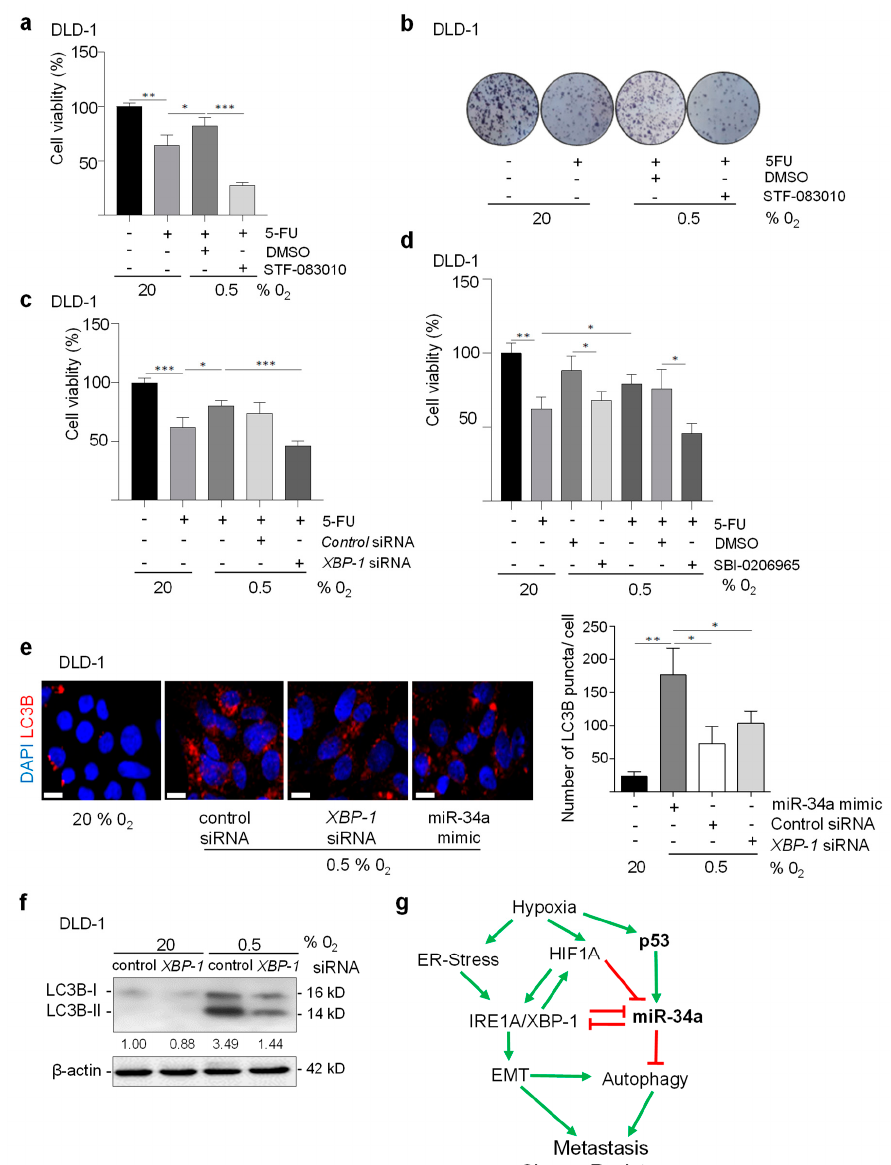
Figure 8. Induction of XBP-1(S) is required for hypoxia-induced autophagy and chemo-resistance. ( a ) MTT assay of DLD-1 cells treated with DMSO or STF-083010 for 24 h at 20.0% O 2 , then exposed to 0.5% O 2 for 48 h, and subsequently treated with or without 5-FU for 72 h. ( b ) Representative examples of crystal violet staining of DLD-1 cells treated with DMSO or STF-083010 for 24 h at 20.0% O 2 , then exposed to 0.5% O 2 for 48 h, and subsequently treated with or without 5-FU for 72 h. ( c ) MTT assay of DLD-1 cells transfected with XBP-1 or control siRNAs for 24 h at 20.0% O 2 , then exposed to 0.5% O 2 for 48 h, and subsequently treated with or without 5-FU for 72 h. ( d ) MTT assay of DLD-1 cells treated with DMSO or SBI-0206965 (10 µ M) for 24 h hours at 20.0% O 2 , then exposed to 0.5% O 2 for 48 h, and subsequently treated with or without 5-FU for 72 h. ( e ) Indirect immunofluorescence detection of LC3B in DLD-1 cells transfected with XBP-1 , control siRNAs or pre-miR-34a for 24 h then exposed to 0.5% O 2 for 48 h. ( f ) Western blot analysis of LC3B in DLD-1 cells transfected with XBP-1 or control siRNAs exposed to 20% or 0.5% O 2 for 48 h. ( g ) The HIF1A/IRS1A/XBP1/miR-34a regulatory circuit: Schematic model summarizing the findings of this study. Green arrows represent stimulatory and red lines inhibitory effects. Loss or mutation of p53/miR-34a in CRCs may enhance the indicated, pro- tumorigenic processes. In ( a , c – e ) mean values ± SD (n = 3) are provided. (***) p < 0.001, (**) p < 0.01, (*) p <